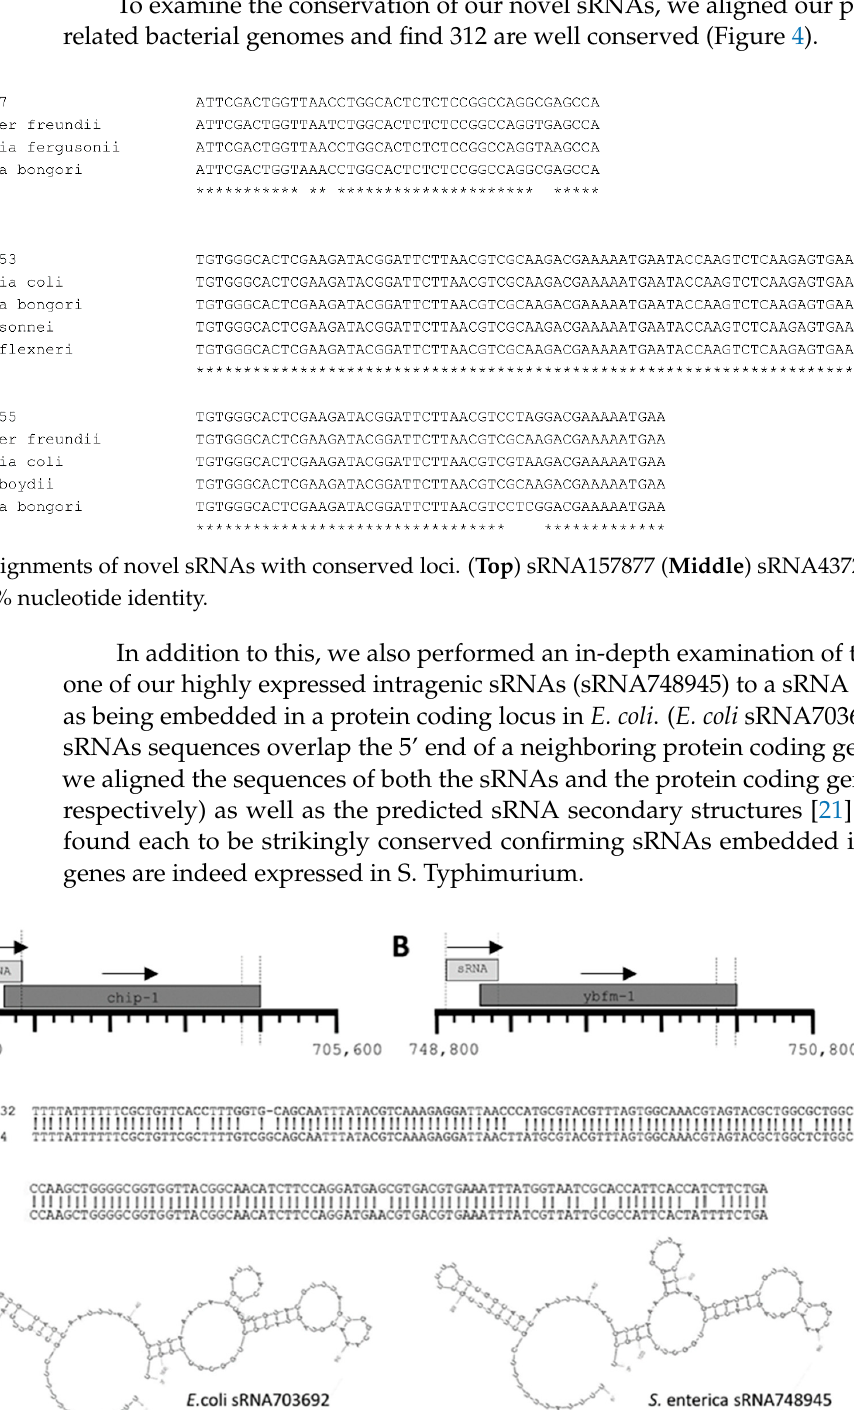
Figure 3. Overlapping sRNAs and protein coding genes have distinct expressions. ( A ) Gene expressions measured at distinct locations within the shared sRNA1529092/ynfl1 locus. ( B ) Illustration depicting locations aligned to RNA seq data to determine expressions shown in ( A ). ( C ) Gene expressions measured at distinct locations within the shared sRNA3420128/ygjG-1 locus. ( D ) Illustration depicting locations aligned to RNA seq data to determine expressions shown in ( C ). Chromosomal start and stop positions for each protein coding gene and sRNA are listed. Transcriptional direction is indicated by an arrow just above a sRNA / gene name.